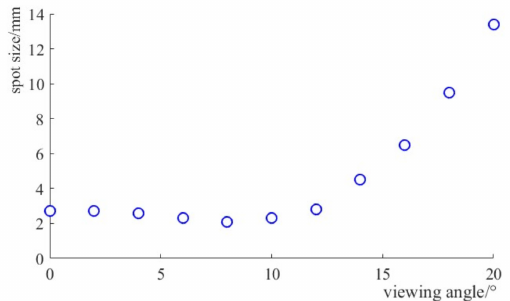
Figure 3. The relationship between viewing angle and spot sizes in simulation.